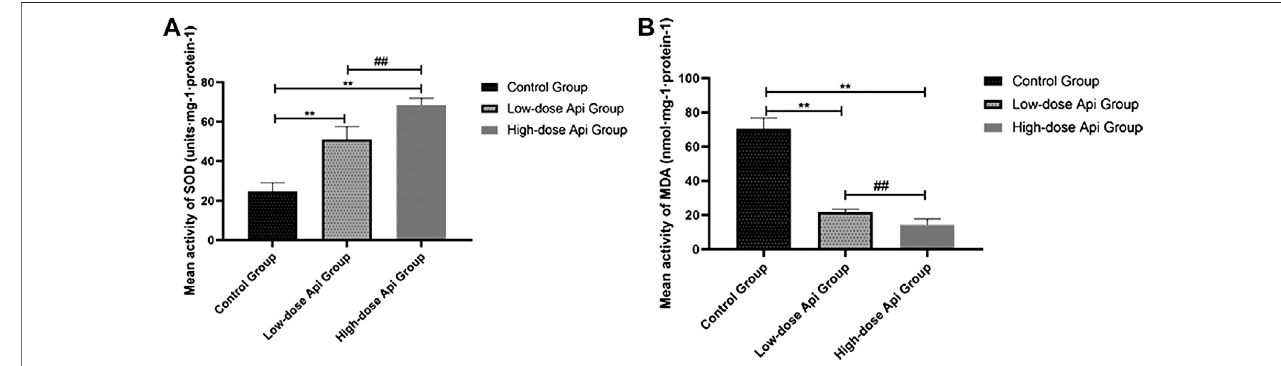
FIGURE8|(A) MeanSODactivityonday7. (B) MeanMDAcontentonday7.ApienhancedSODactivityandinhibitedtheexpressionofMDA.** p < 0.01vs.control group. ## p < 0.01 vs. Low-dose Api